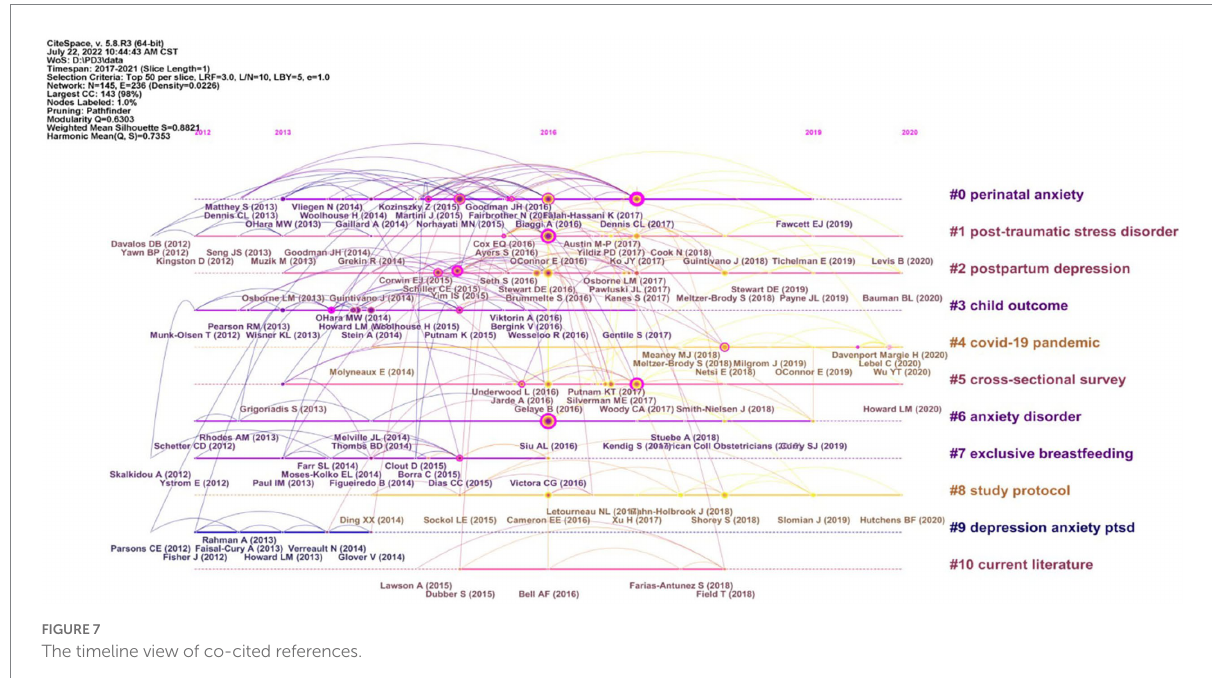
FIGURE 7 The timeline view of co-cited references.